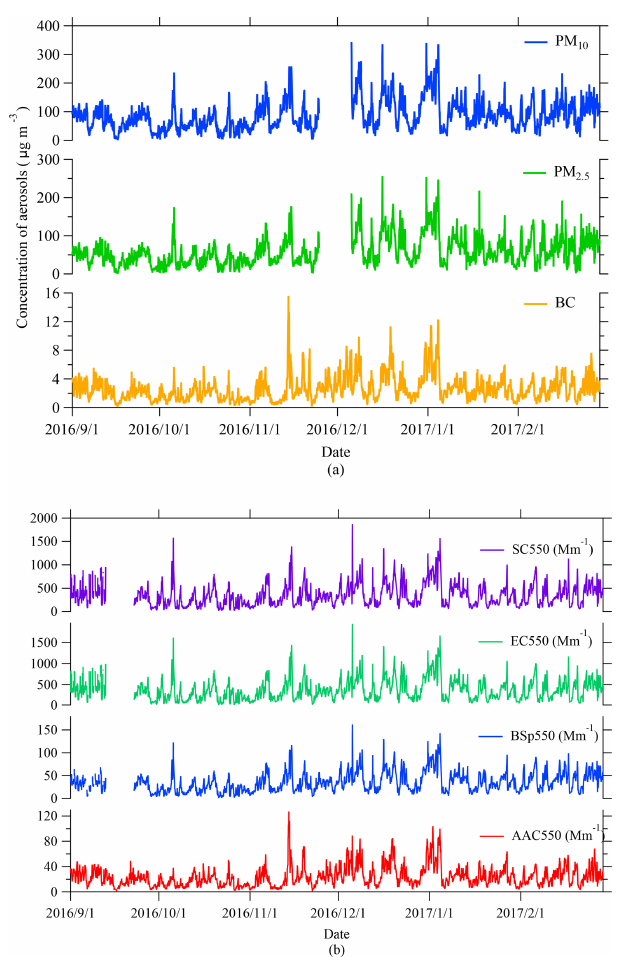
Figure 1. Time series of (a) concentrations and (b) optical proper- ties of PM 10 , PM 2 . 5 , and BC at the Gulou site from September 2016 to February 2017.